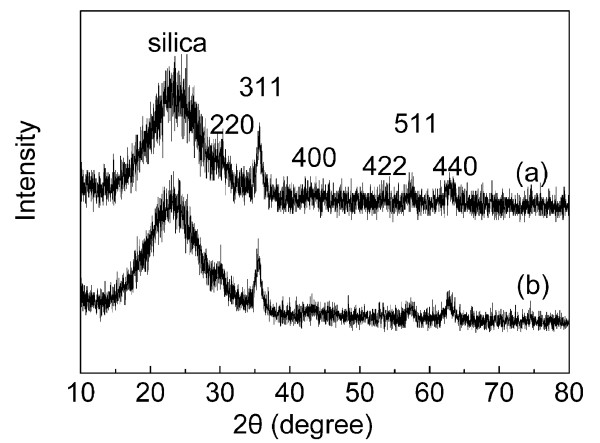
XRD patterns of Fe3O4@SiO2 (a) and DTH-Fe3O4@SiO2 (b).